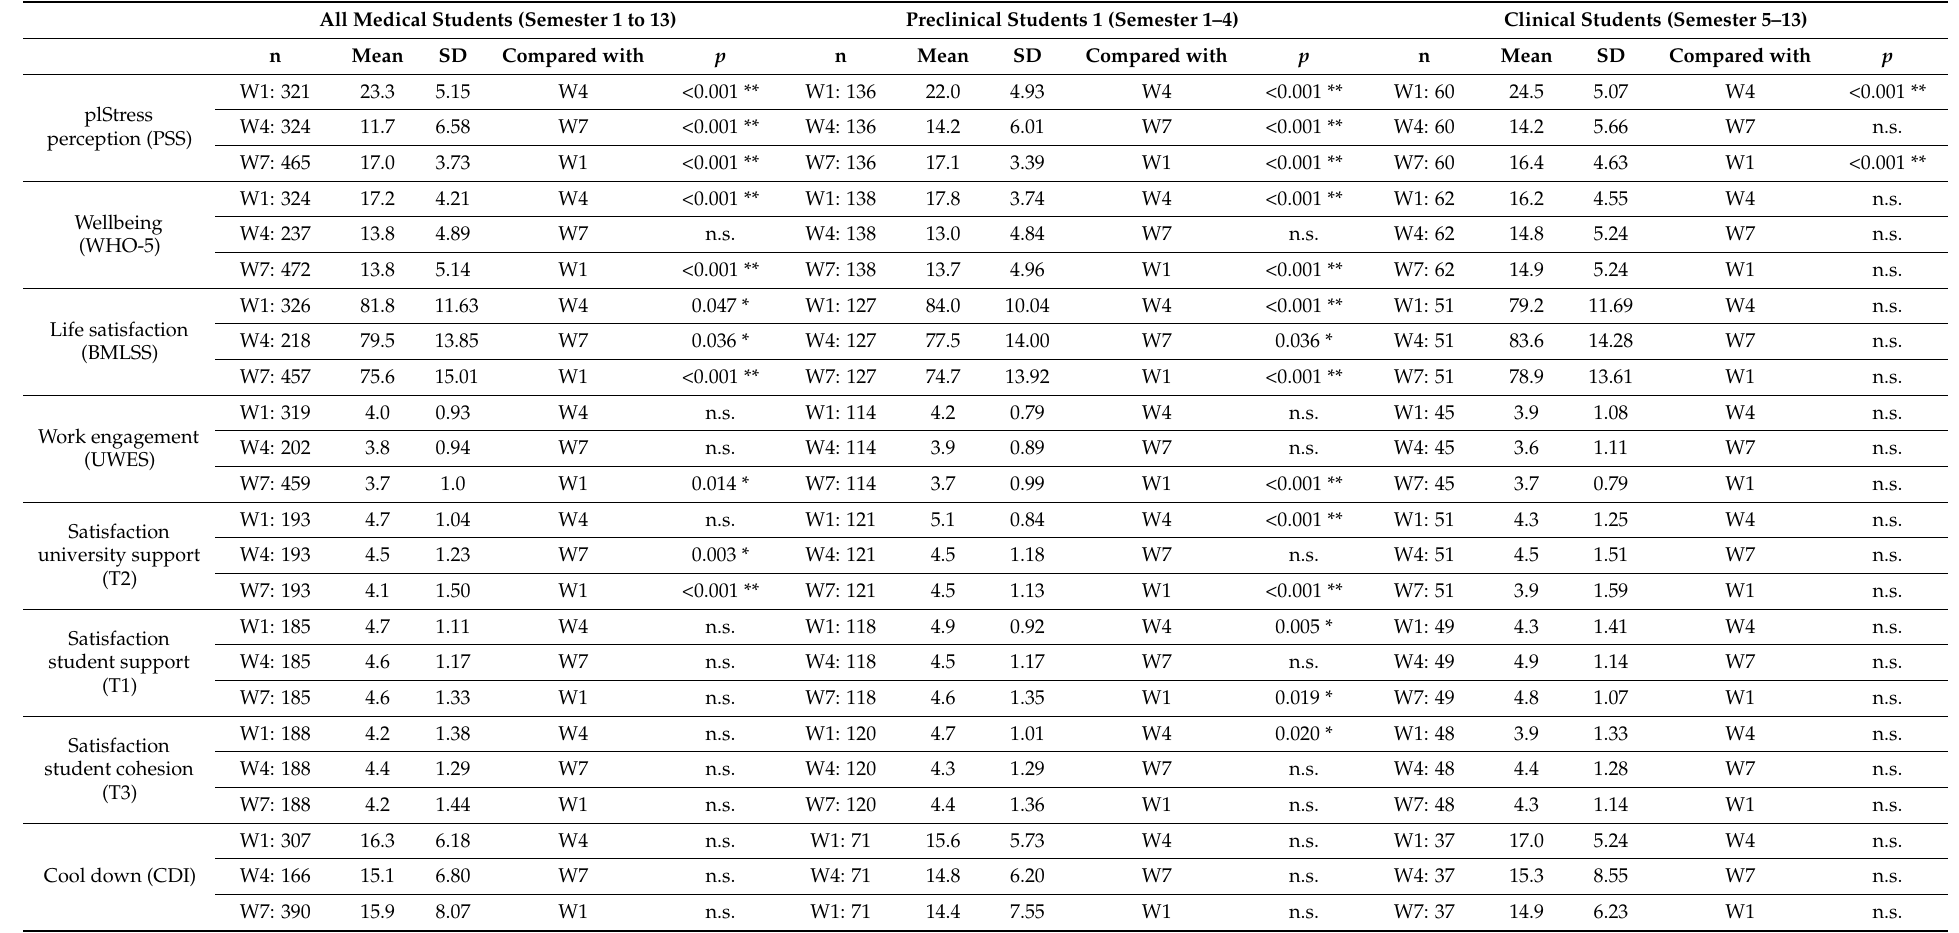
Table 2. Indicators of stress and wellbeing in medical students of waves 1, 4 and 7 differentiated for the phase of their study. All Medical Students (Semester 1 to